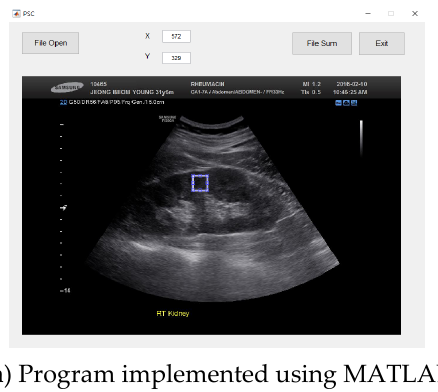
Figure 3. Program implementation.